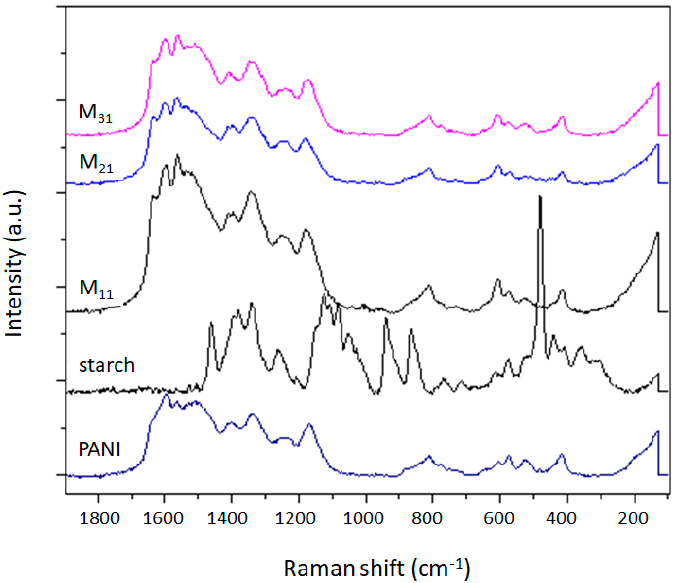
Figure 4. RAMAN spectra of PANI, starch, and PANI/starch